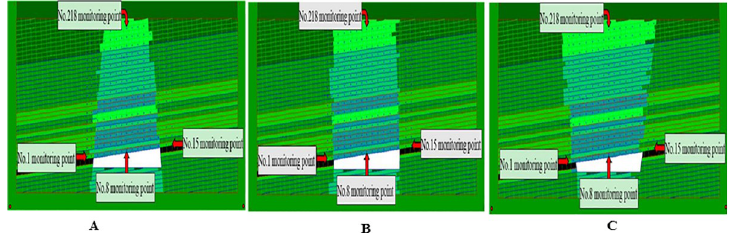
Fig 12. Numerical model of three typical collapse column. (A) Inverted funnel. (B) Columnar. (C)